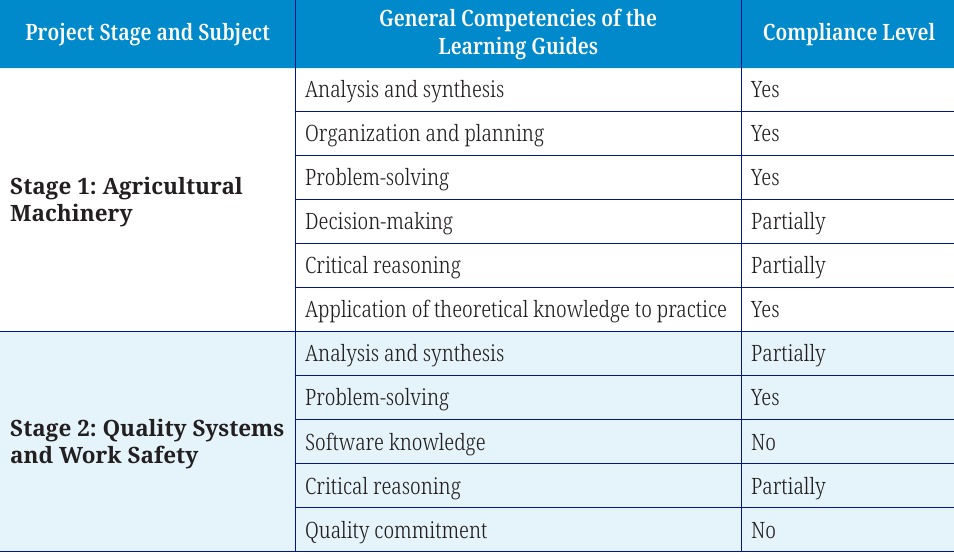
Table 1. Compliance level of general competencies in each stage of the teaching-innovation